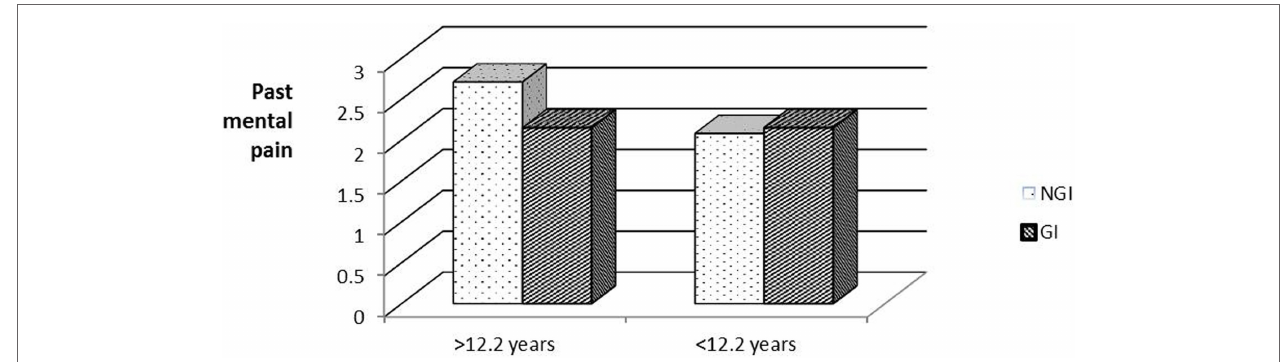
FigUre 1 | Past mental pain by age at diagnosis groups and information groups .